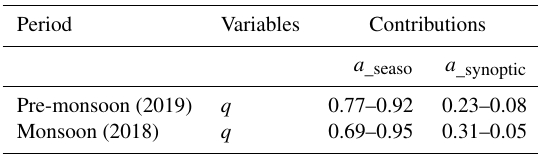
Table 3. The same as Table 2, but for reanalysis q